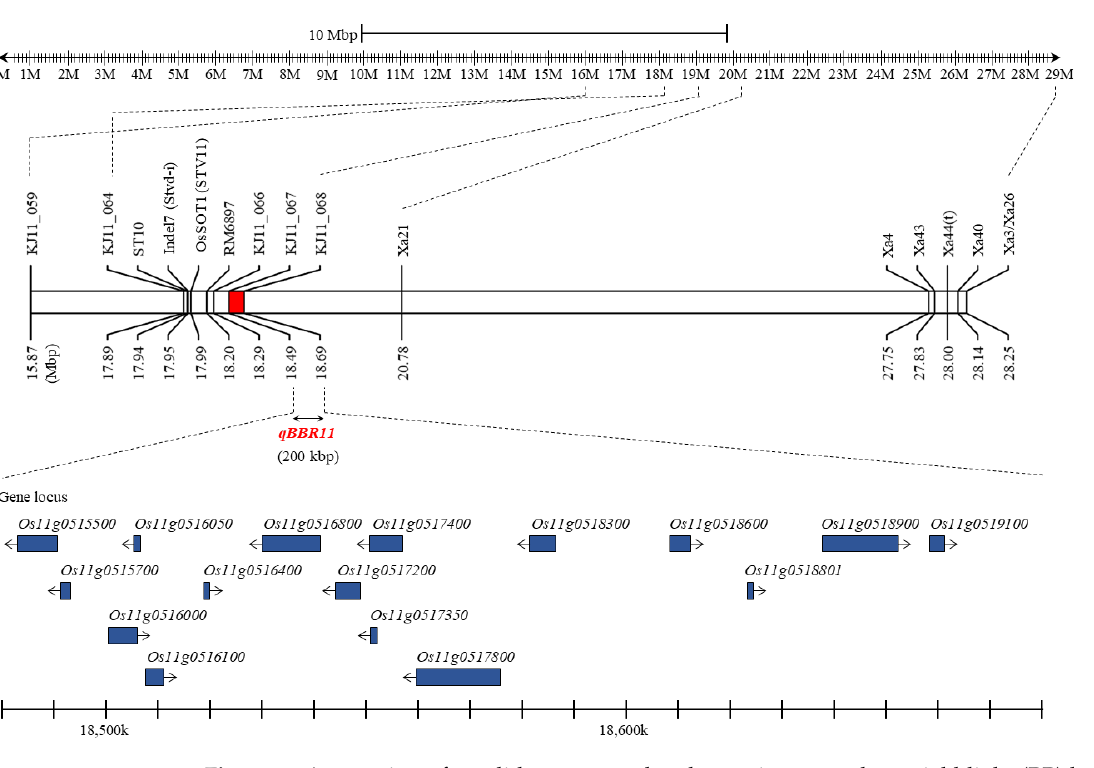
Figure 3. Annotation of candidate genes related to resistance to bacterial blight (BB) by physical mapping. QTLs related to BB resistance were detected in the 200 kbp region between KJ11_067 and KJ11_068 of chromosome 11. In qBBR11 detected on chromosome 11, there are 16 candidate genes annotated by comparison with the sequence of Nipponbare. In the region adjacent to qBBR11 , the gene OsSOT1 related to rice stripe virus resistance and ST10, Indel7, and RM6897, molecular markers that detect rice stripe virus resistance, were identified together, and the BB resistance gene Xa21 was also identified. Table 4. Candidate genes associated with BB at qBBR11 and variation-induced single nucleotide polymorphisms (SNPs) between JJ623 and HR27195.